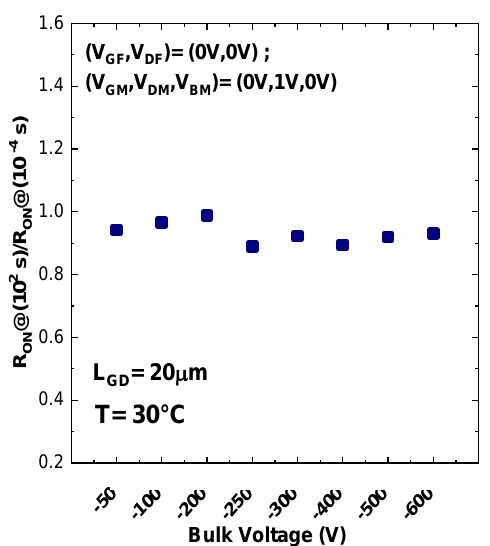
Figure 11. Normalized on-resistance at 100 s over on-resistance at 100 µs as a function of bulk voltage during the backgating measurement on the sample with SL. No significant variation was detected.